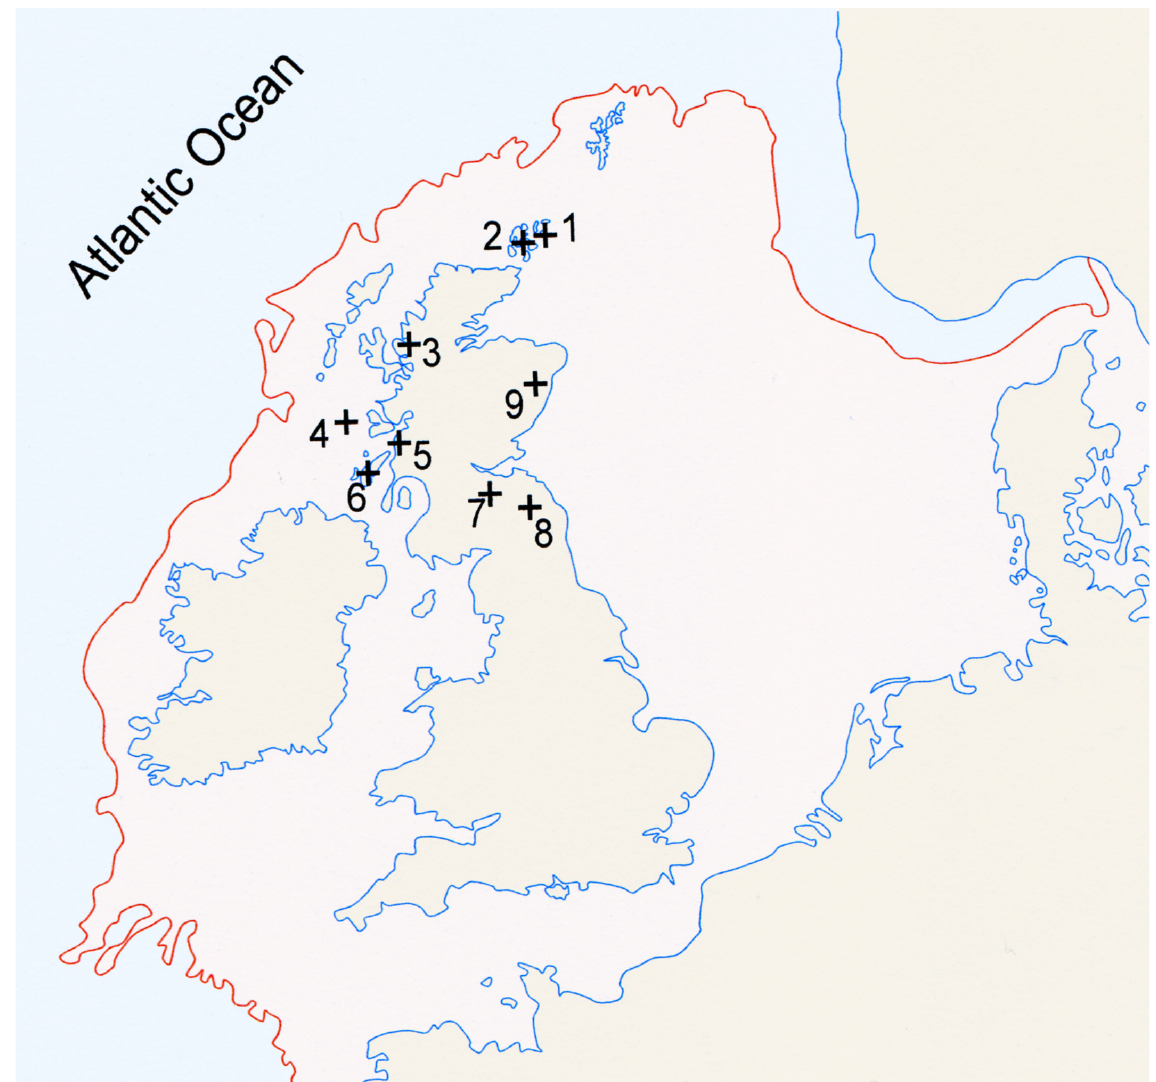
Figure 1. Map of find locations mentioned in the text in relation to the potential shores of Doggerland c. 16,000 BCE, after Spinney 2012 (drawn by TBB). The main Scottish sites of the Late Upper Palaeolithic period in the area are noted: 1) Millfield, Stronsay, Orkney and Links House, Stronsay, Orkney; 2) Brodgar, Mainland, Orkney; 3) Shieldaig, Loch Torridon; 4) Isle of Tiree, Inner Hebrides; 5) Kilmelfort Cave, Oban; 6) Rubha Port an t-Seilich on the Isle of Islay; 7) Howburn, South Lanarkshire; 8) Fairnington, Scottish Borders; 9) Nethermills Farm,